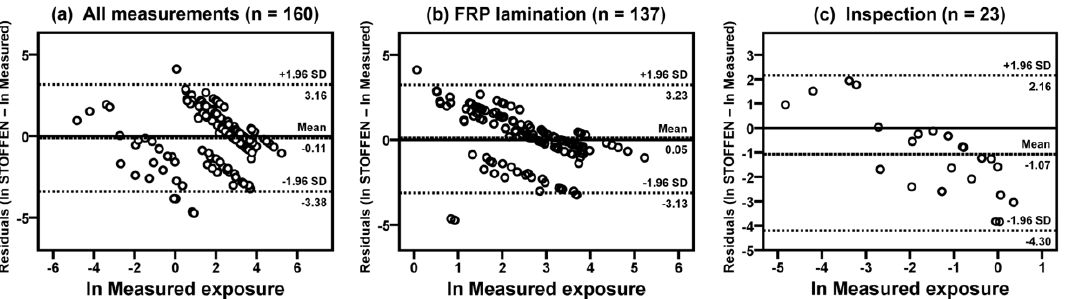
Figure 4. Residual plots of the differences between the log-transformed model estimations (daily average or 90th) of Stoffenmanager and exposure measurements for styrene collected on the FRP lamination and inspection tasks on individual level. The mean differences with 95% upper and lower limits of agreement are marked with the dashed lines.